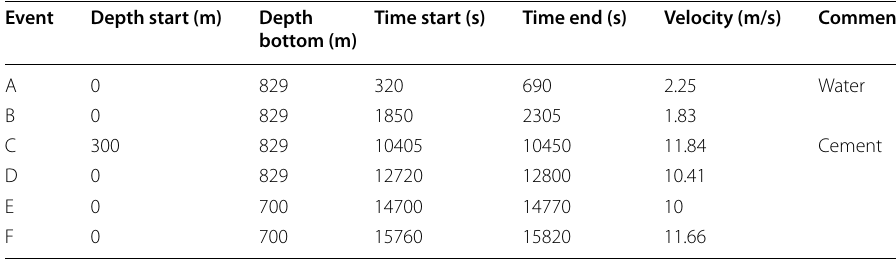
Table 3 Fluid speed in annulus (see events marked in Fig.